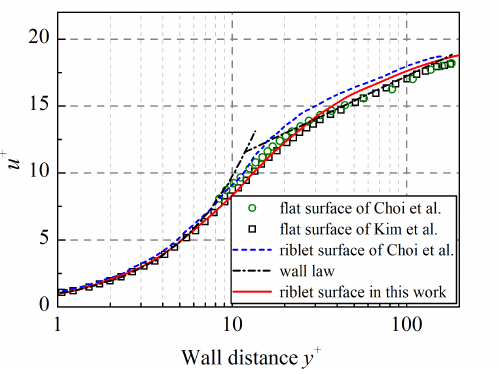
Figure 9. Comparison work of velocity profiles in the present work with DNS results in [9,43]. Then, the comparison work between the modified SST-RC model in this work and the numerical method of Catalano et al. [31] is conducted. In the work of Catalano et al. [31], a ω model is used to evaluate the flow over riblets, and the mean velocity profile modified k − on the riblet surface is compared with that of the flat plate. In [31], the single parameter l + is used, and l + = 10.5, which corresponds to the maximum drag reduction ratio. In this work, two parameters, h+ and h + / s + , are used, and the maximum drag-reducing effect is accomplished in the case of h + = s + = 15, which is corresponding to the case of l + = 10.5 in [31]. Then, the results of the simulation in this work and [31] are compared, as shown in Figure 10.